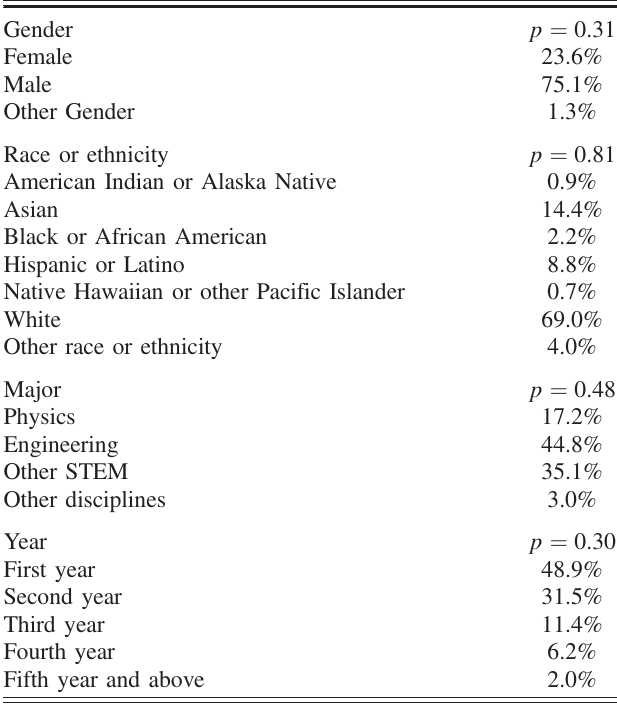
TABLE III. Self-reported gender, race or ethnicity, major, and year of students enrolled in the course in both Spring 2017 and Spring 2018. “ Engineering ” excludes the major Engineering Physics, which is included in “ Physics. ” The p values from Fisher ’ s exact test comparing the two semesters appear next to each dimension